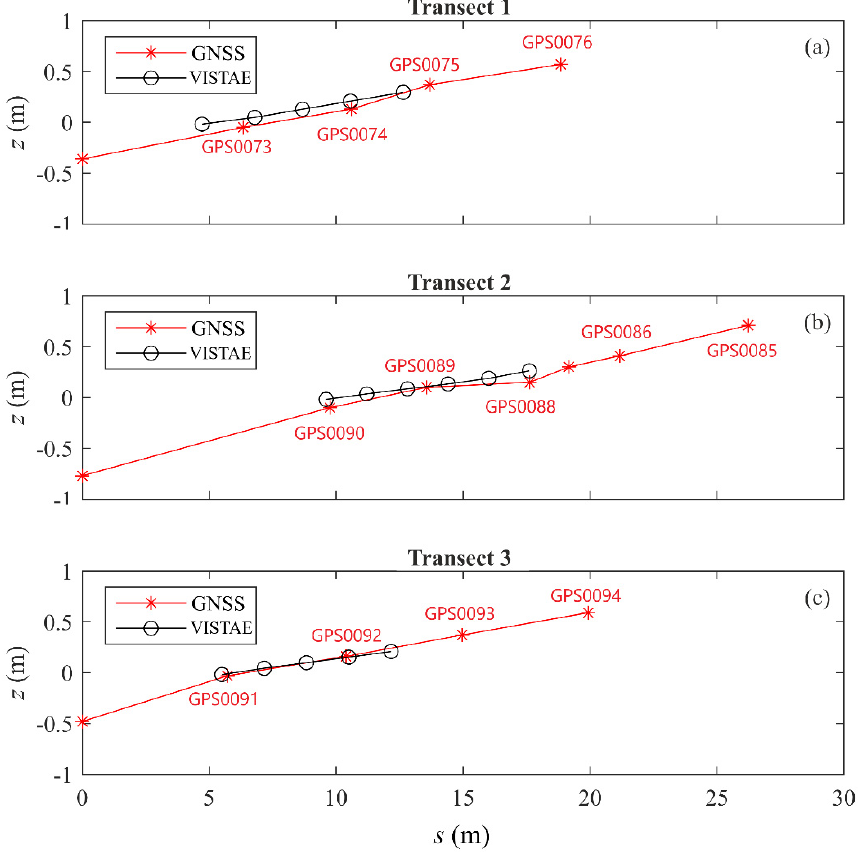
Figure 7. Comparison between transects (see Figure 2a for planimetric position) measured by the GNSS (red lines) and extrapolated by the low-cost camera VISTAE (black lines). The red numbers indicate the same GPS points indicated in Figure 6a.